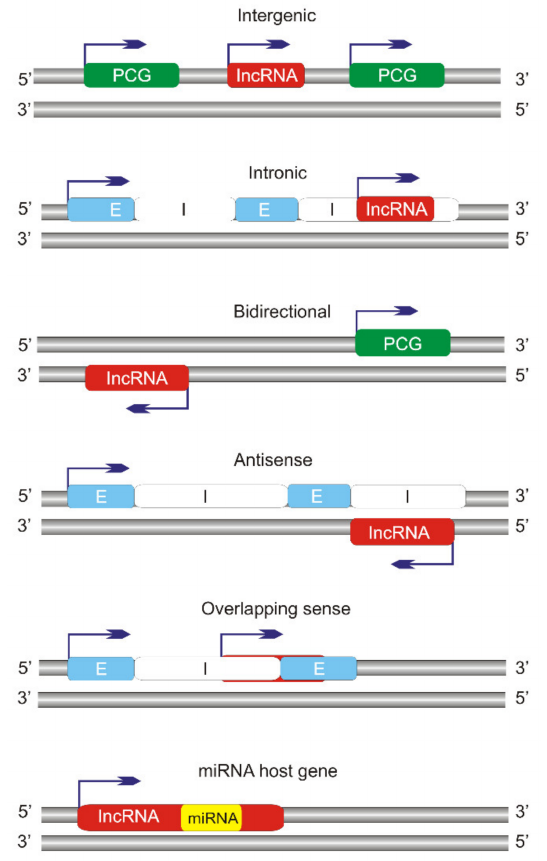
Figure 2. Classification of long non-coding RNAs (lncRNAs) according to orientation and location of their genes with respect to protein-coding genes (PCGs). Introns and exons are designated as I and E, respectively. Intergenic lncRNAs do not overlap, even in part, with any PCG, and they are also called long or large intergenic non-coding (linc) RNAs. Intronic lncRNAs are located within PCG introns and may adopt many shapes, including circular intronic (ci) RNAs produced from lariat introns. Bidirectional lncRNAs originate from the opposite strand to transcribed PGC strand. Antisense lncRNAs are a common feature of the human genome and are “natural” antisense transcripts (NATs). Overlapping sense lncRNAs are located within PCGs with overlapping exons and are transcribed in the same sense direction as PCGs. Micro RNAs (miRNAs) or a cluster of miRNA genes can host a lncRNA